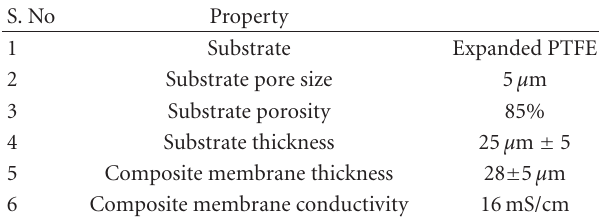
Table 1: Properties of the composite membrane.